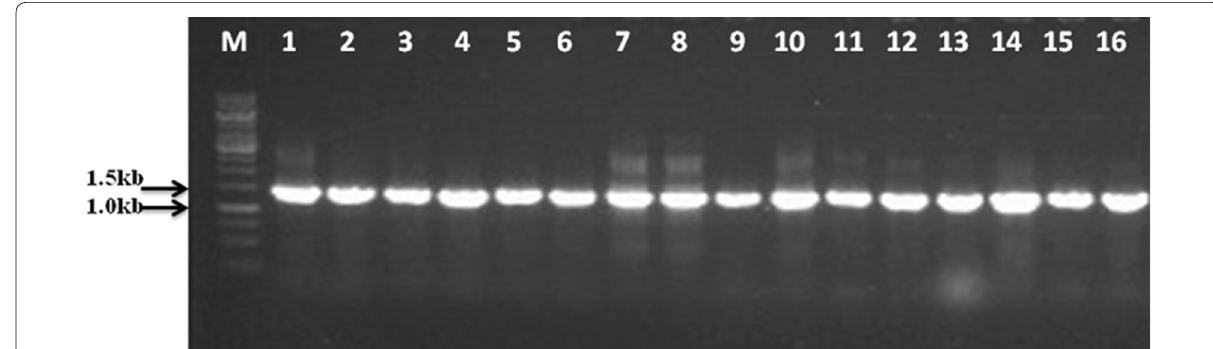
a IUB code for degenerated base positions: B b Positions correspond to the hsp 70( Dna K) nucleotide sequence of S. coelicolor (GeneBank NO. L46700) c Direct sequencing primers for hsp 70-U7F/ hsp 70-1326R